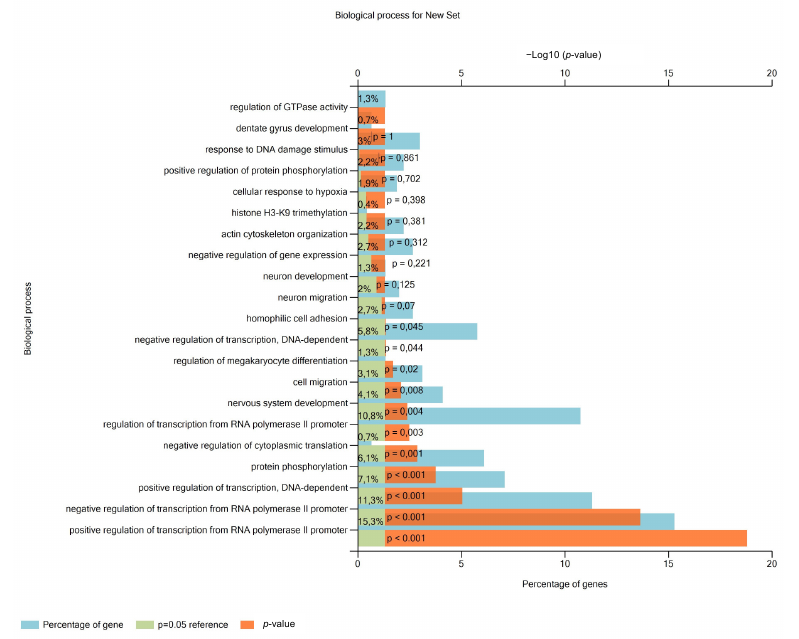
Figure 3. miR-302a-3p protein target-related pathways. Top 20 biological processes regulated by miR-302a-3p predicted targets, using FUNRICH and the Gene Ontology database.